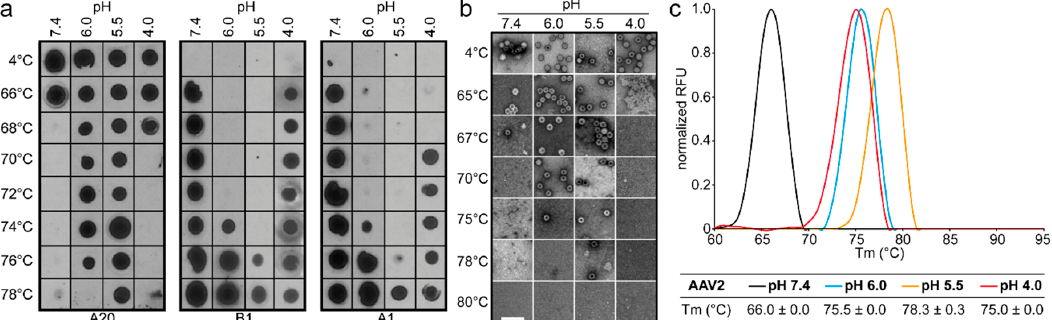
Figure 2. AAV2 stability analysis. ( a ) Dot immunoblots of AAV2-GFP vectors at different pHs representative of physiological (7.4), early endosomal (6.0), late endosomal (5.5), and lysosomal (4.0) conditions. The virus was heat-shocked at the temperature indicated and blotted for intact capsids (A20), denatured capsids (B1), and the accessibility of VP1u (A1). ( b ) Negative-stain EM of AAV2-VLPs treated as in ( a ). Scale bar: 100 nm. ( c ) T m of AAV2-VLPs determined by DSF at the pH conditions used in ( a ) and ( b ). A thermal profile for each pH condition is shown as normalized relative fluorescence units (RFUs) versus temperature (in °C). All experiments were performed in triplicate. The AAV5 capsids displayed the highest T m of the AAV serotypes assayed and a trend which was different to AAV1 and AAV2 (and AAV8 below). At pH 7.4, intact capsids were detected by dot